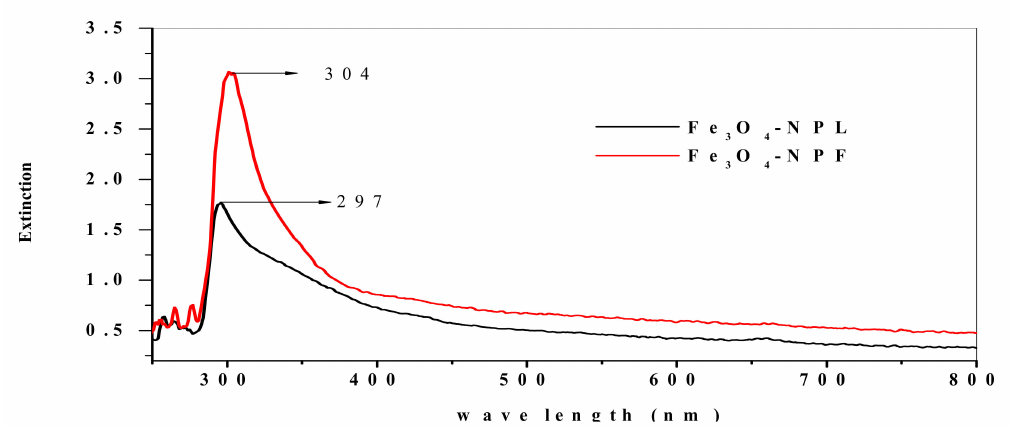
Figure 4. UV–visible spectra of Fe 3 O 4 -NPL and Fe 3 O 4 -NPF synthesized by leaf and flower extracts, respectively.